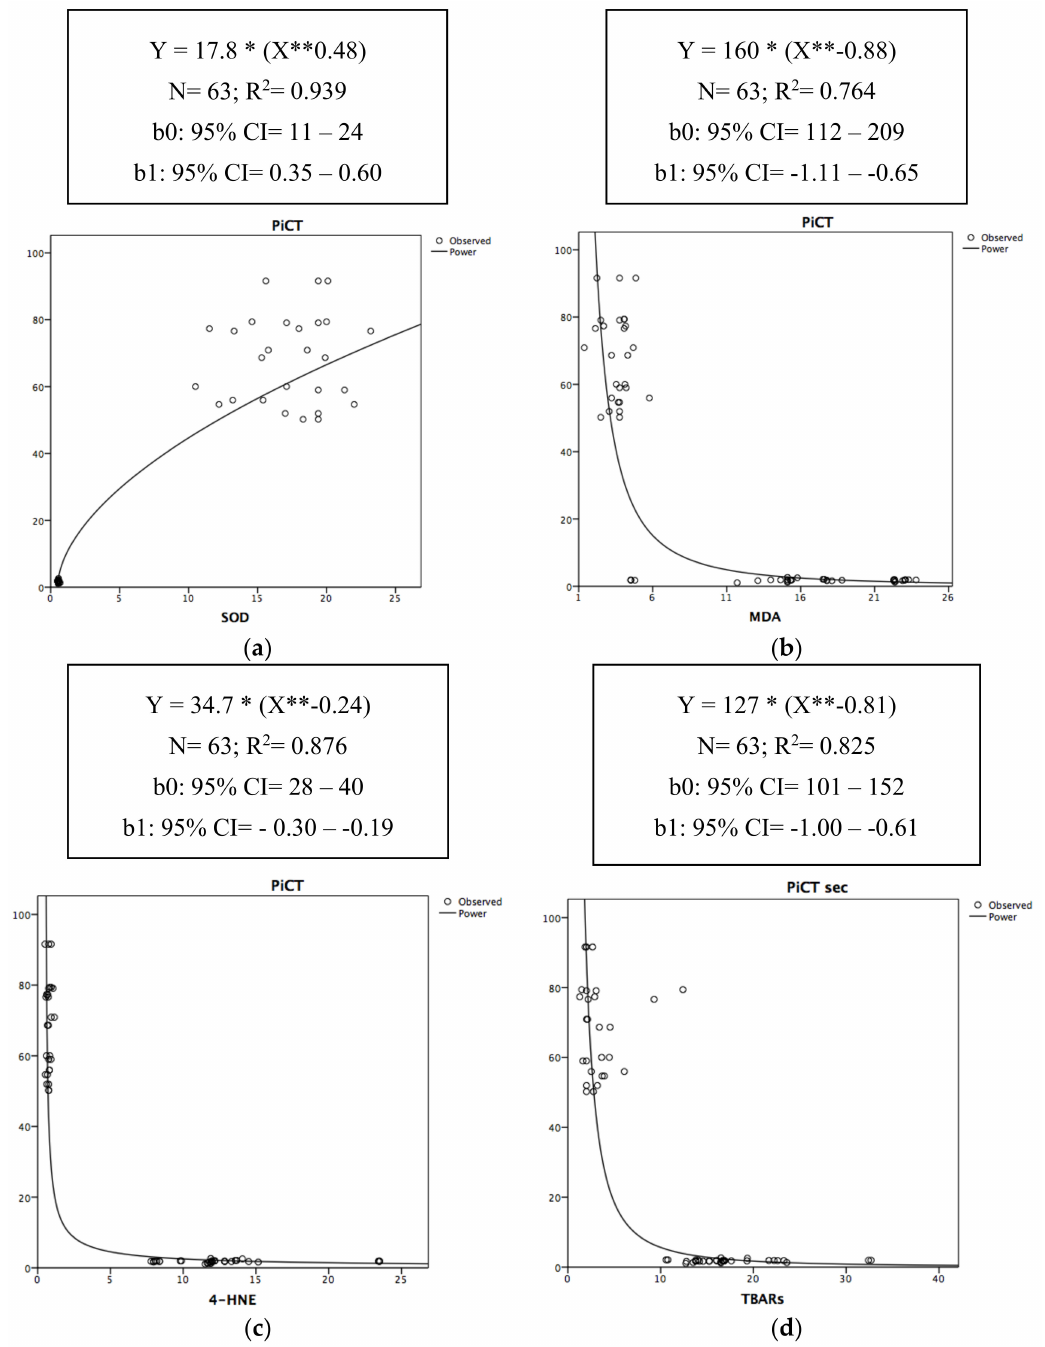
Figure 2. ( a – d ) Non-linear scatter diagrams of determination between PiCT and SOD ( a ), MDA ( b ), 4-HNE ( c ), TBARs ( d ). R 2 = the value of R 2 (in terms of percentage) expresses the percentage of the variability of the outcome (PiCT) that can be explained by the predictor. *: the asterisk in the curve equation equals to the “ × ” sign of multiplication. **: the two asterisks in the curve equation equals to “X”